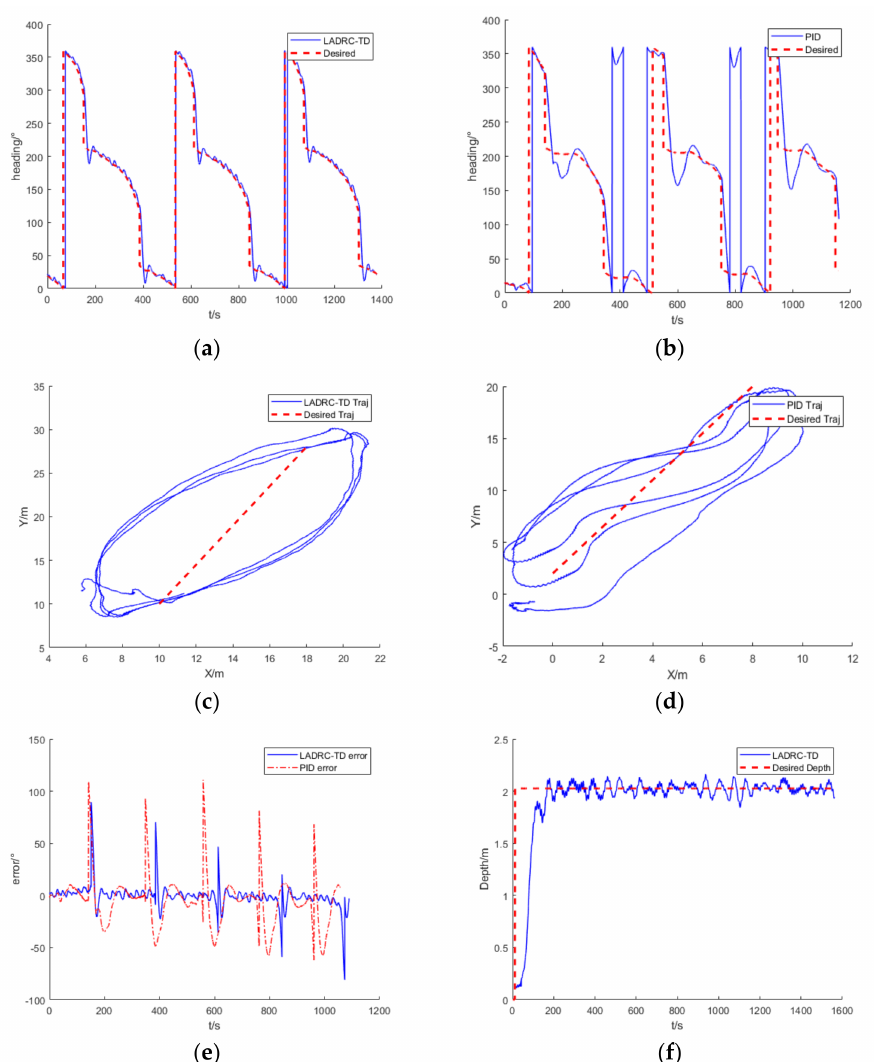
Figure 12. Dynamic experiment: ( a ) heading tracking with LADRC-TD; ( b ) heading tracking with PID; ( c ) trajectory when using LADRC-TD in heading control; ( d ) trajectory when using PID in heading control; ( e ) heading tracking error of PID and LADRC-TD in dynamic experiment; ( f ) depth- keeping with LADRC-TD during AUH